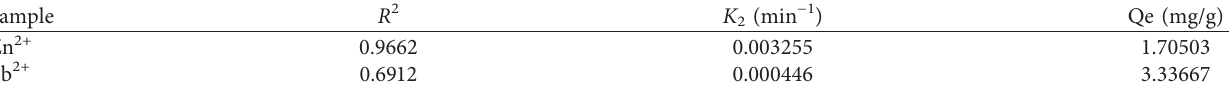
Table 4: A summary of the pseudo-second-order reaction kinetic model parameters.